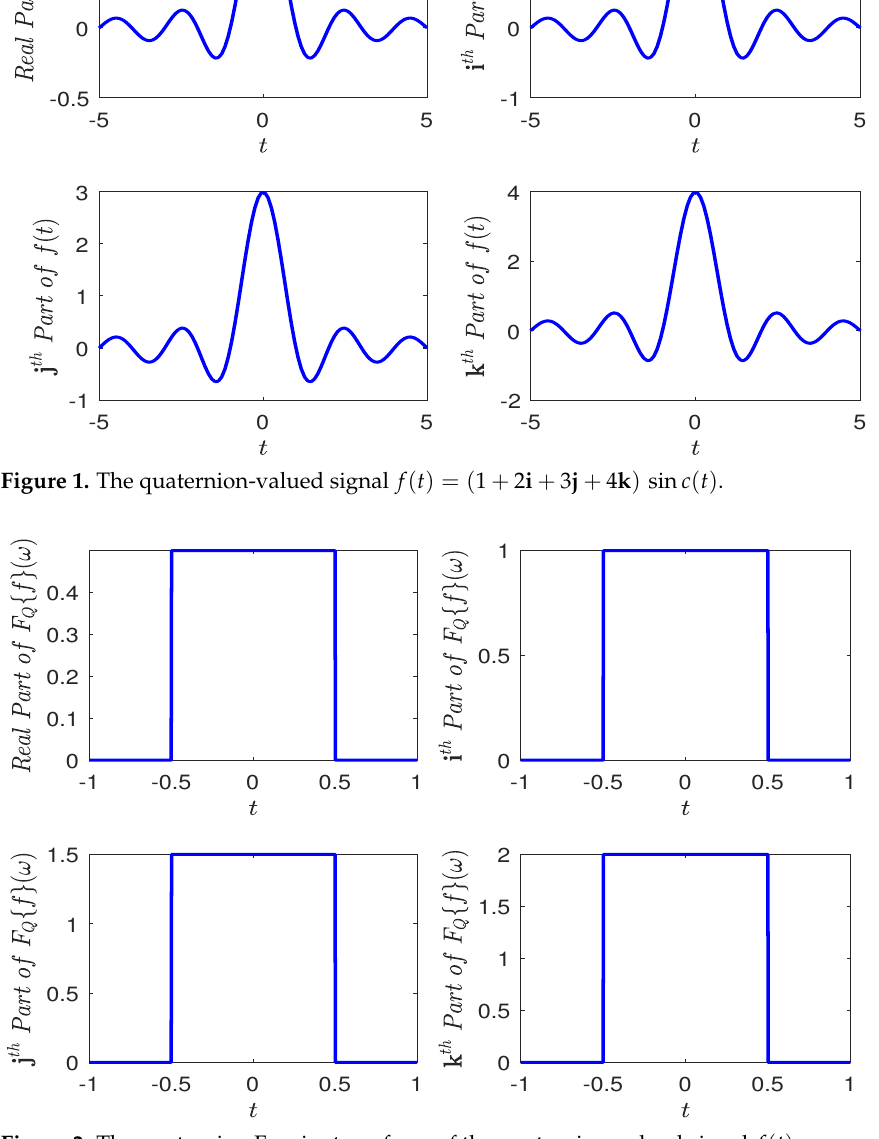
Figure 2. The quaternion Fourier transform of the quaternion-valued signal f ( t ) . The sampled signal f ( nT 0 ) is plotted in Figure 3, whereas the reconstructed signal (27) is plotted in Figure